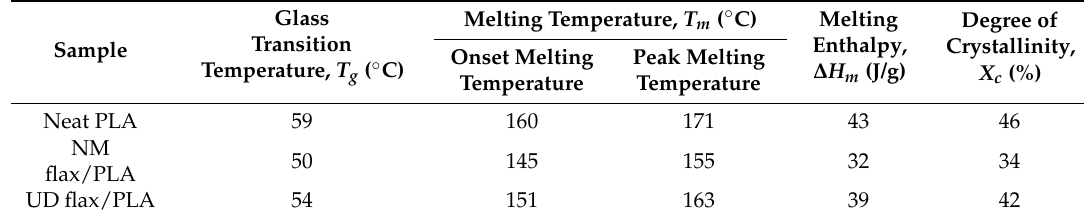
Table 4. Thermal properties of neat PLA and flax/PLA biocomposites.